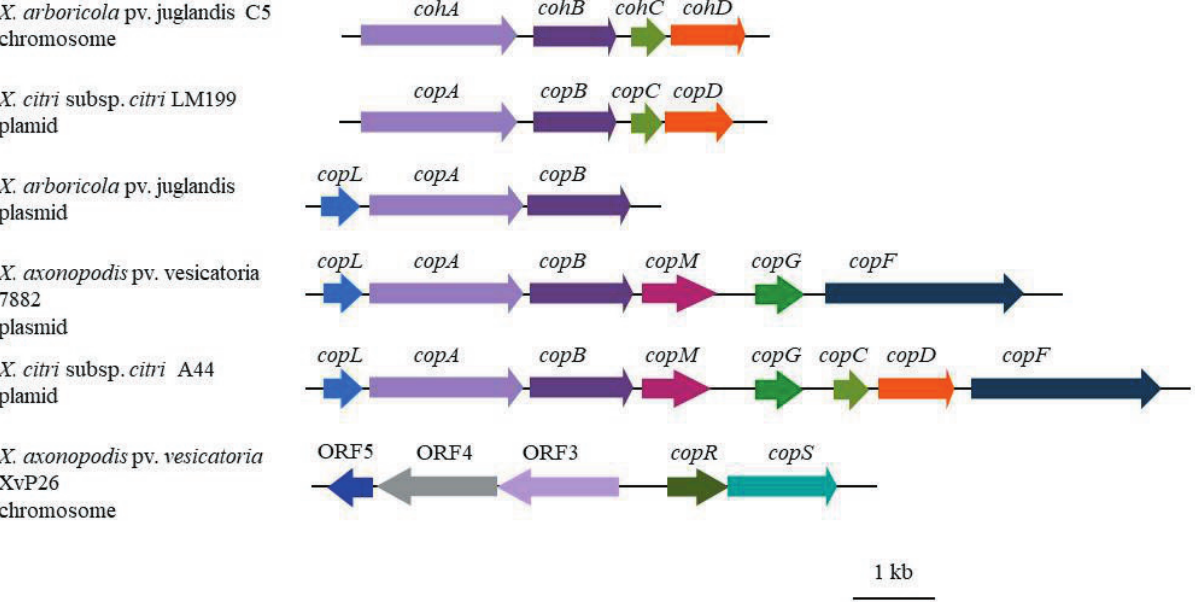
Figure. 2. The genetic arrangement and composition of copper resistance genes in Xanthomonas strains. Areas with the same colour indi- cate homologous genes among the strains. Chromosome indicates the corresponding gene cluster located in the chromosome. Plasmid rep- resents the gene cluster present in a